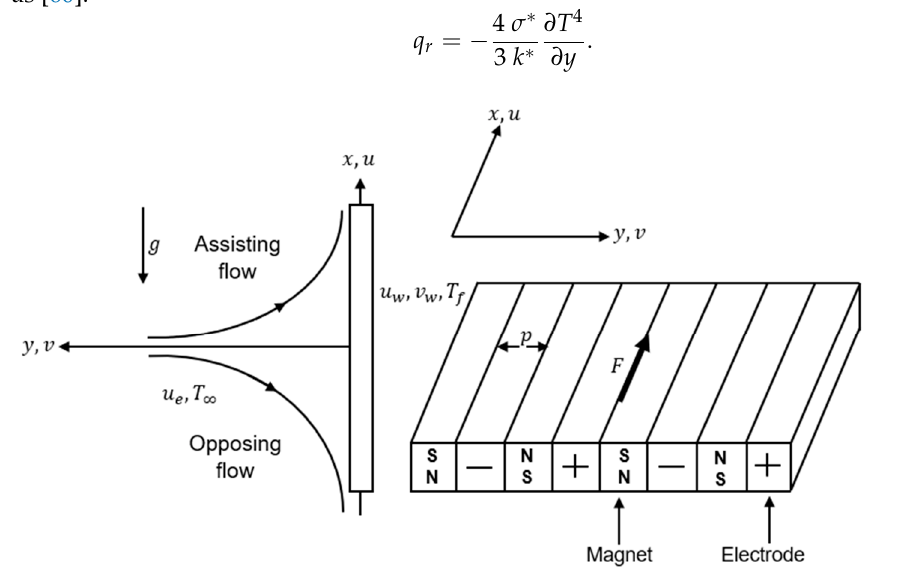
Figure 1. Schematic representation of the flow problem.